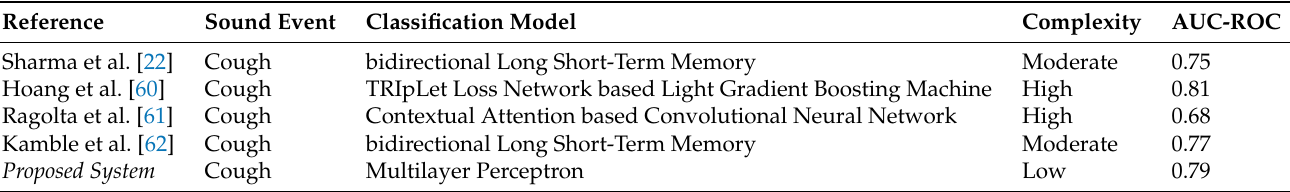
Table 2. Feature dimensionality, classification model, and classification performance comparison to other proposed systems in the literature. All AUC-ROC scores reported for the systems compared were obtained when testing on the DiCOVA Blind Test